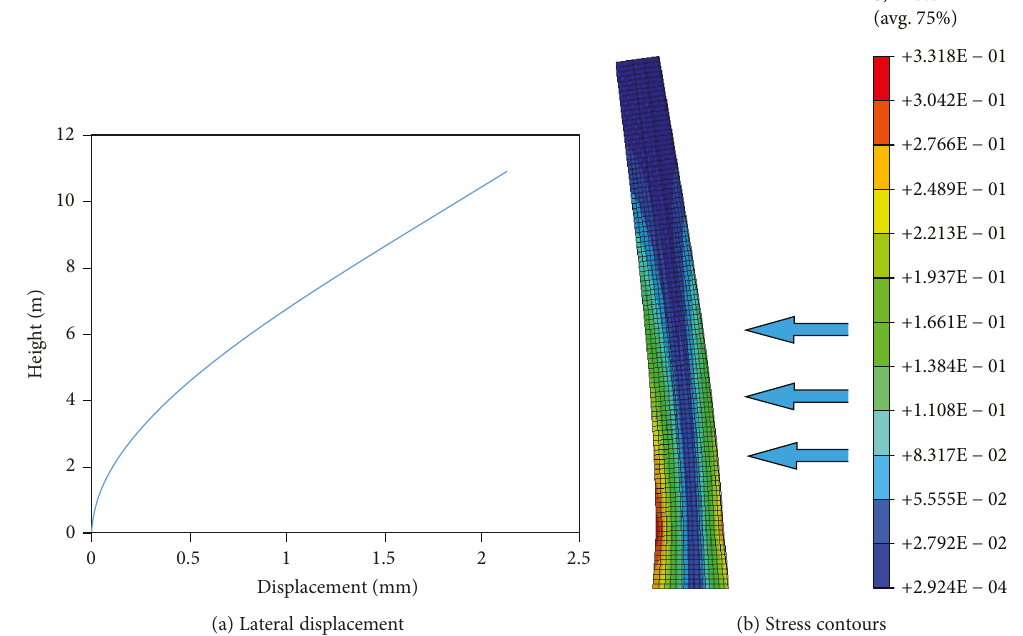
Figure 5: (a) Lateral displacements and (b) stress contours along the height of an unreinforced tree stem subjected to a wind load.